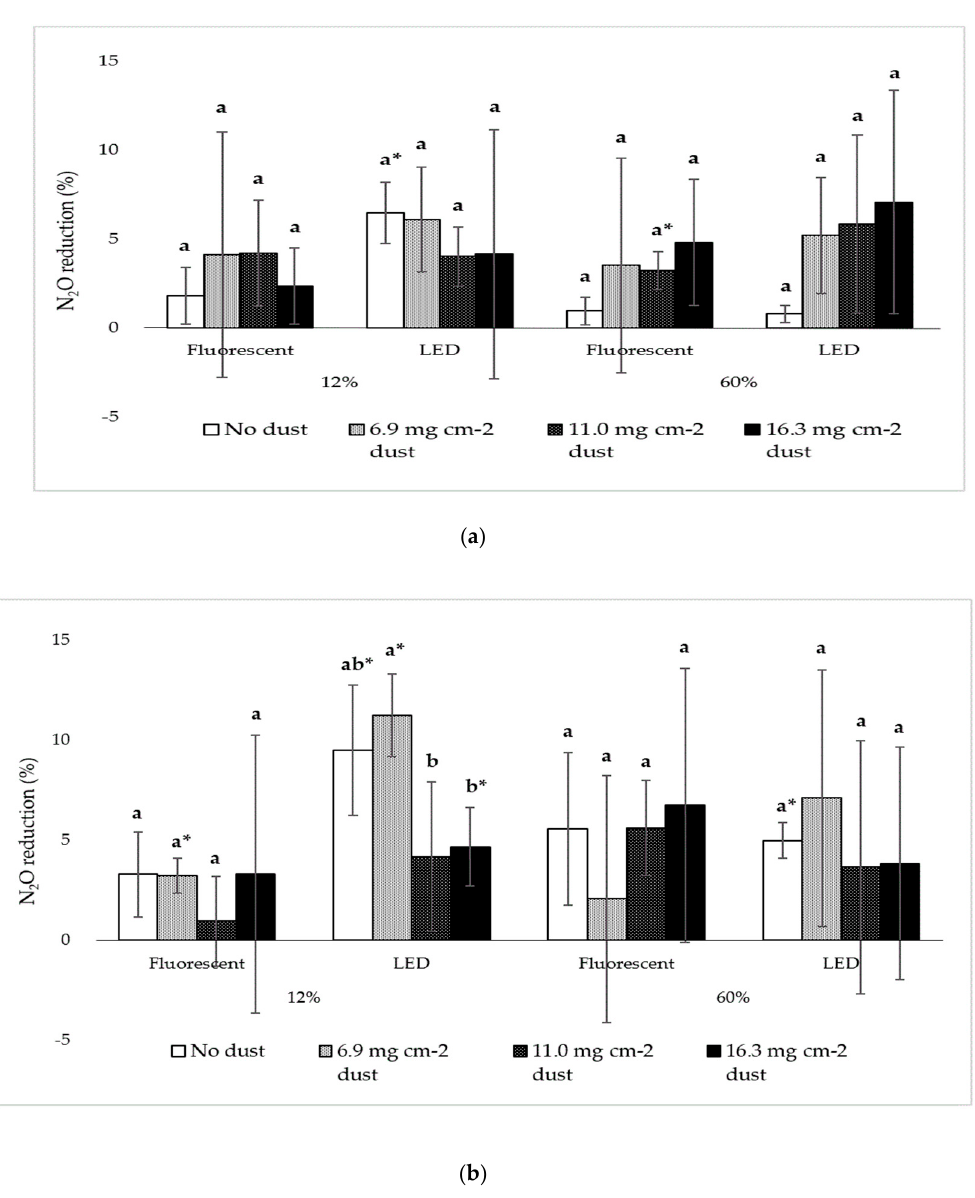
Figure 14. Comparison of N 2 O mitigation under di ff erent poultry dust levels at 200 s of treatment time. ( a ) % reduction at a relative humidity of 12% and 60% in direct photolysis; ( b ) % reduction at a relative humidity of 12% and 60% in photocatalysis. Superscript (*) signifies a statistical di ff erence compared to the control ( p < 0.05), and the di ff erent characters (a, b) signify the statistical di ff erence between treatments associated with one UV lamp type and one relative humidity ( p < 0.05). Error bars signify ± standard deviation.